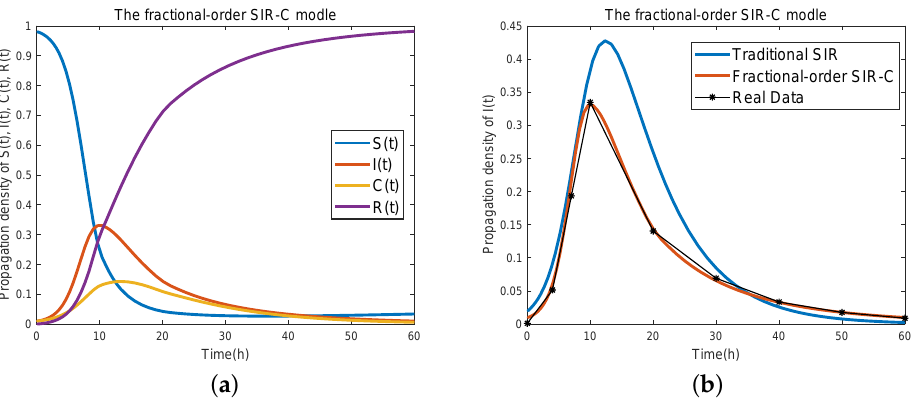
Figure 5. ( a ) The simulation diagram of the fractional-order SIR-C model. ( b ) Consider the effect of different differential orders of α ∈ { 0.9,1,1.3 } on the spread of cyber rumors, for system